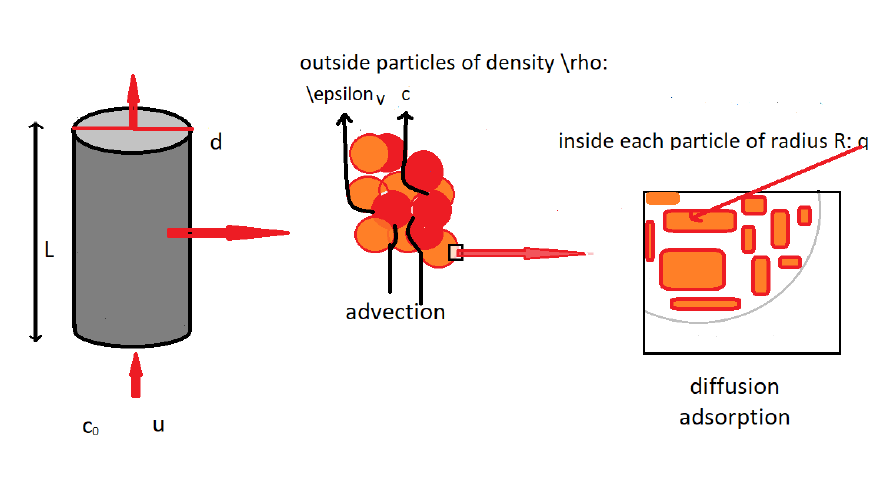
Figure 1. Packed bed of length L and diameter d , filled with porous solid absorbent particles of uniform radius R and density ρ